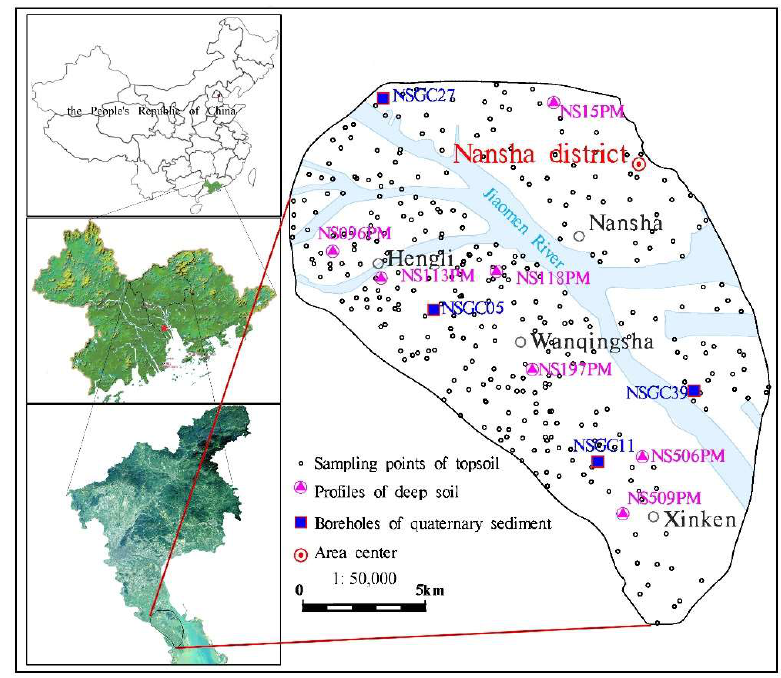
Figure 1. Topsoil sampling sites in Nansha District (Guangzhou, Guangdong Province, China).